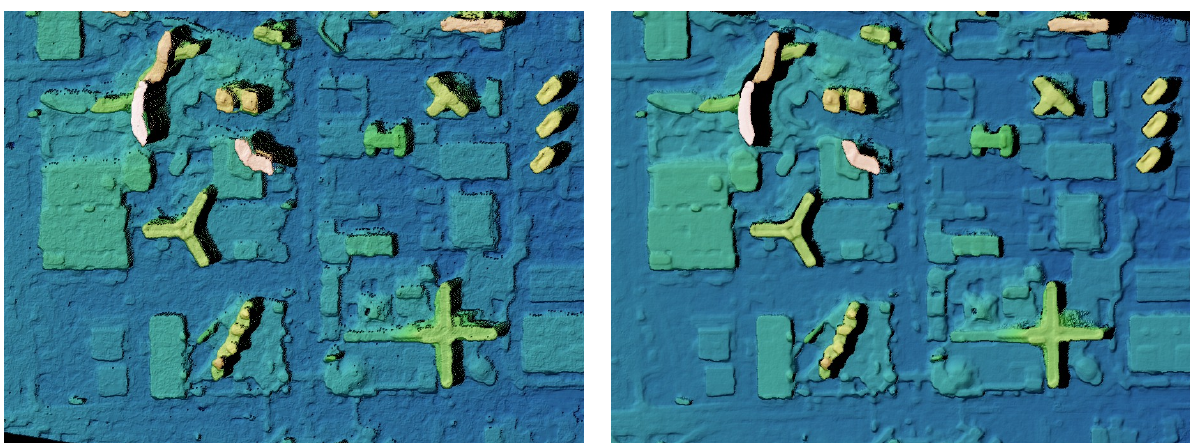
(c) 20 images against one master image, with regularization (d) 15 master images, each matched against 20 slave images. Figure 6: Cutout of the Las Vegas DSMs computed with different matching